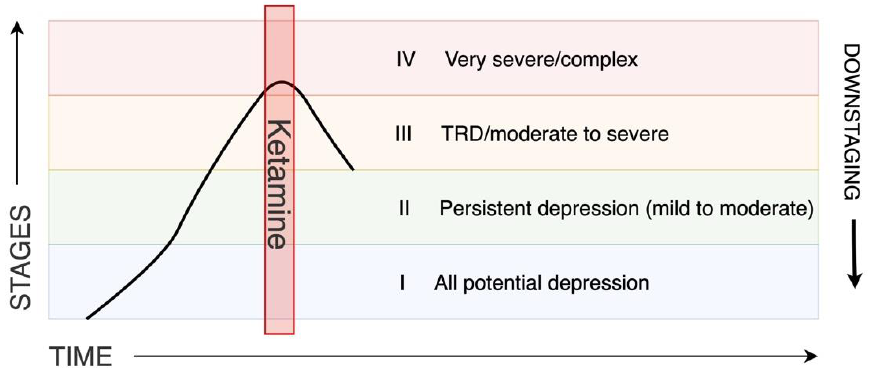
Figure 4. Downstaging concept. Stepped care pathway for depression according to NICE guideline 2009 [26]. TRD (treatment-resistant depression).